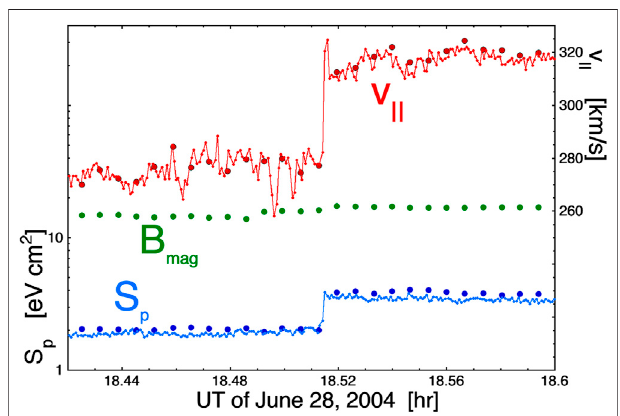
FIGURE1| Anexampleofaverythin streaminterface onJune28, 2004 at 1 AU. Using 3-s resolution (small points) and 15-s resolution (large points) measurements from the WIND spacecraft, the proton speci fi c entropy S p and the magnetic- fi eld strength B mag [nT] are logarithmically plotted with the left axis and the component of the solar-wind fl ow velocity v || parallel to the localParker-spiraldirectionisplottedlinearlyontherightaxis.Each3-spointis separated by ∼ 700 km in the direction perpendicular to the Parker-spiral orientation.